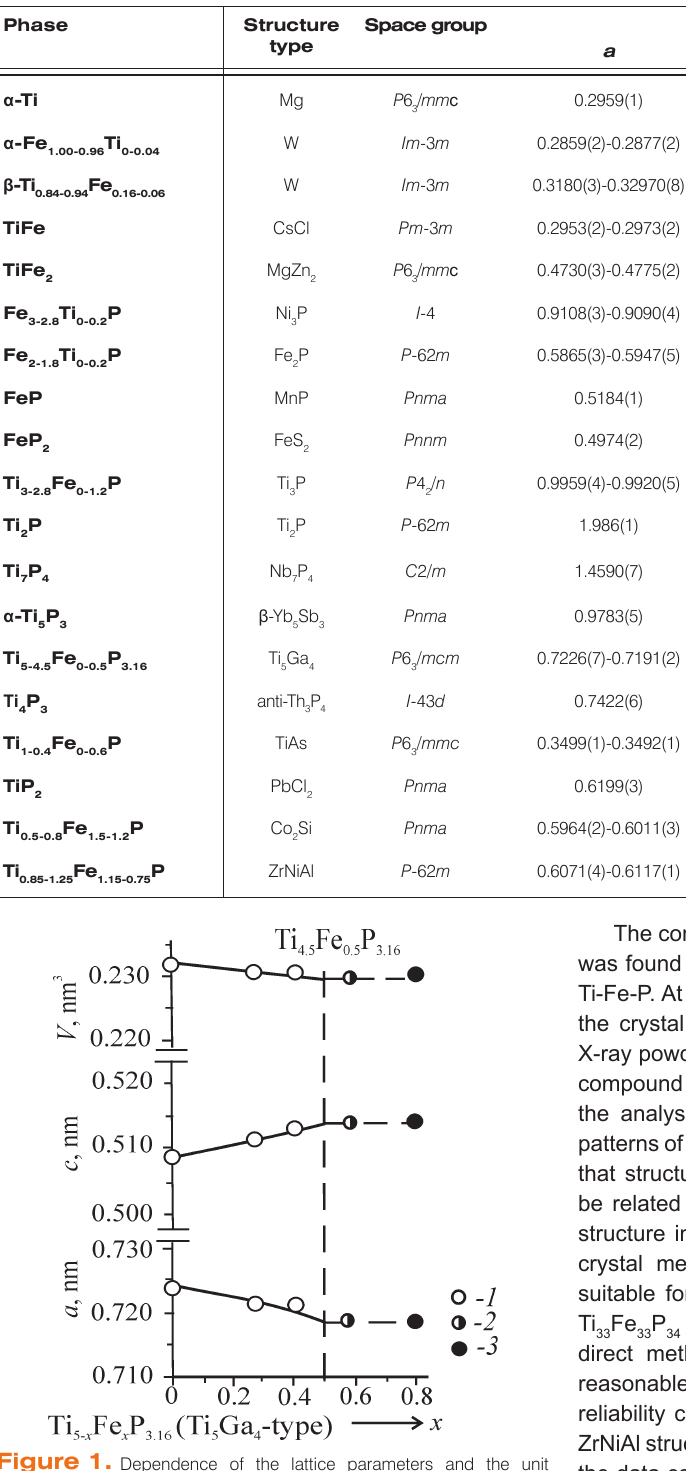
presented in Table 4 .